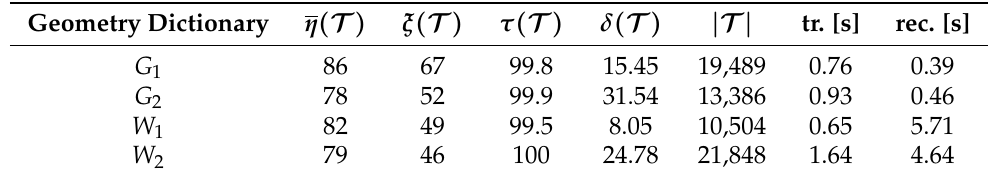
Table 2. Quality measures for the studied geometries. Algorithm: Full recombination combined with preconditioned Delaunay L ∞ frontal meshing algorithm with